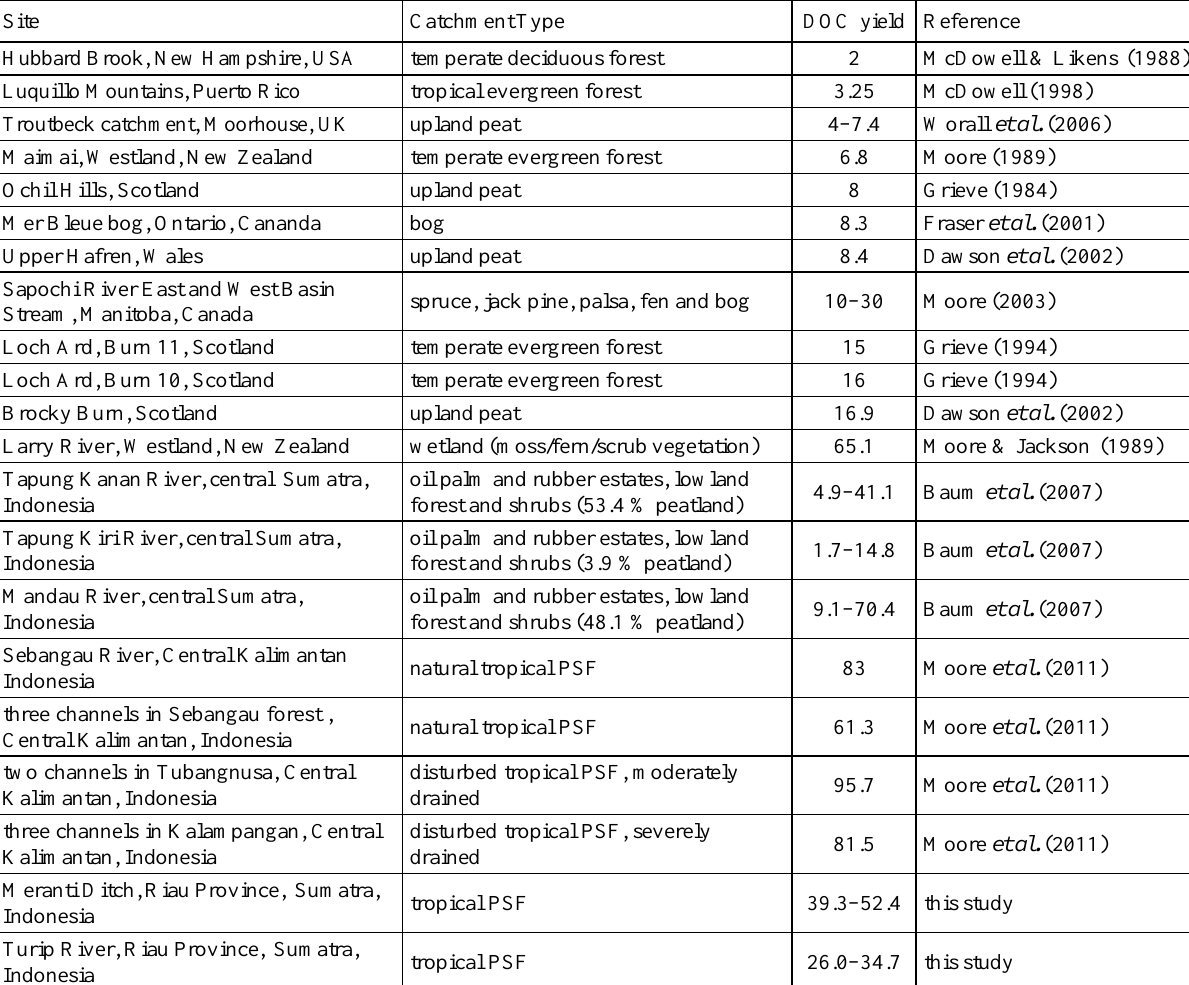
Table 6. DOC yields (g C m -2 yr -1 ) from different catchment types in different regions.